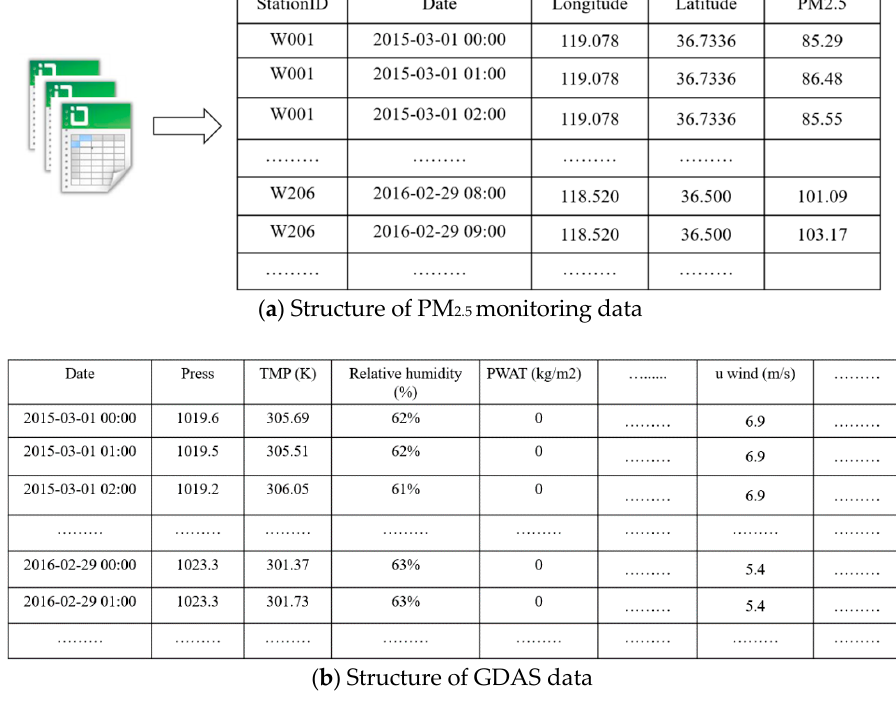
Figure 2. Structures of monitoring station data and GDAS data.